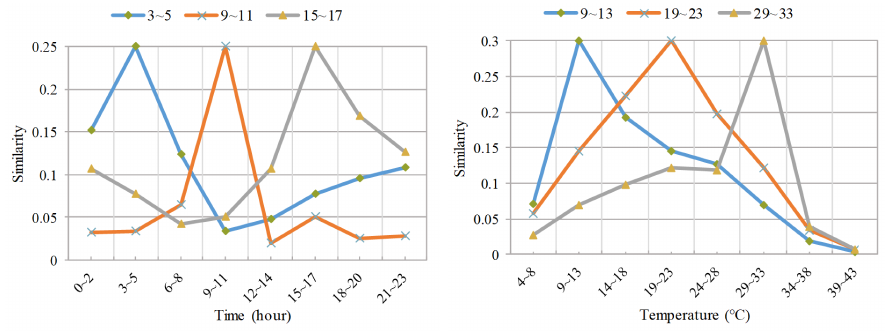
Figure 2. User behavior similarity between different context